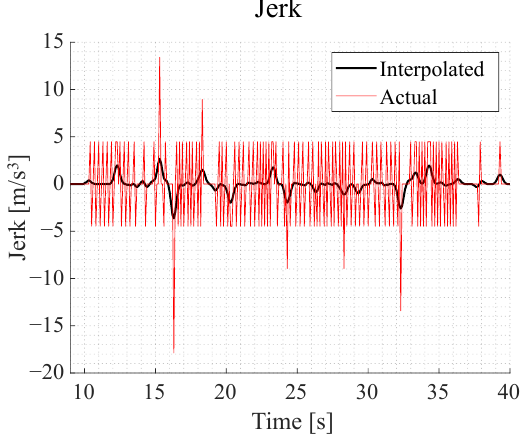
Figure 4. Difference in jerk before ( red ) and after ( black ) data processing. The initial model had jerk values in the module of 15 m/s 3 , which were obviously insurmountable by the city